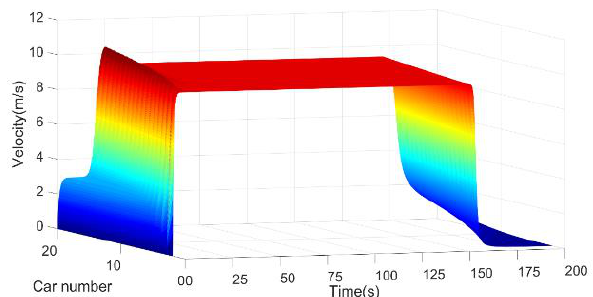
Figure 6. Vehicle velocities in driving situation 4.